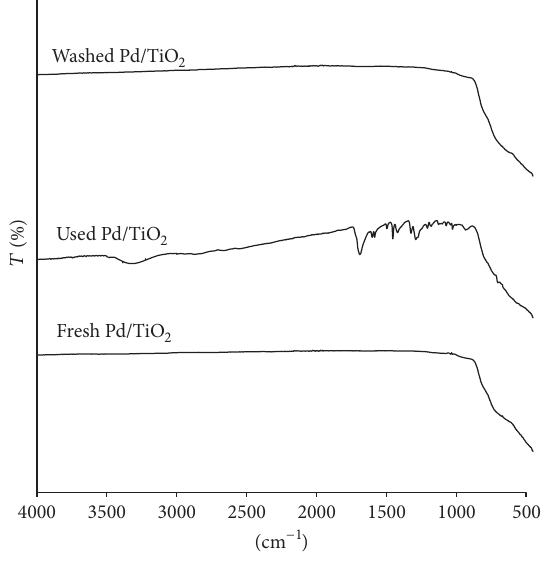
Figure 7: FT-IR spectra of fresh Pd/TiO 2 , used Pd/TiO 2 , and washed Pd/TiO 2 .